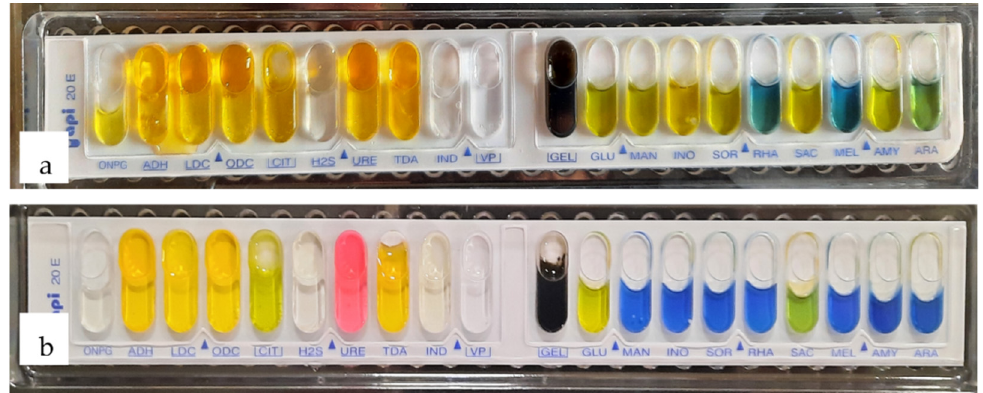
Figure 7. Biochemical tests API 20E Enterobacteriaceae for ( a ) 1B and ( b ) 2D1.